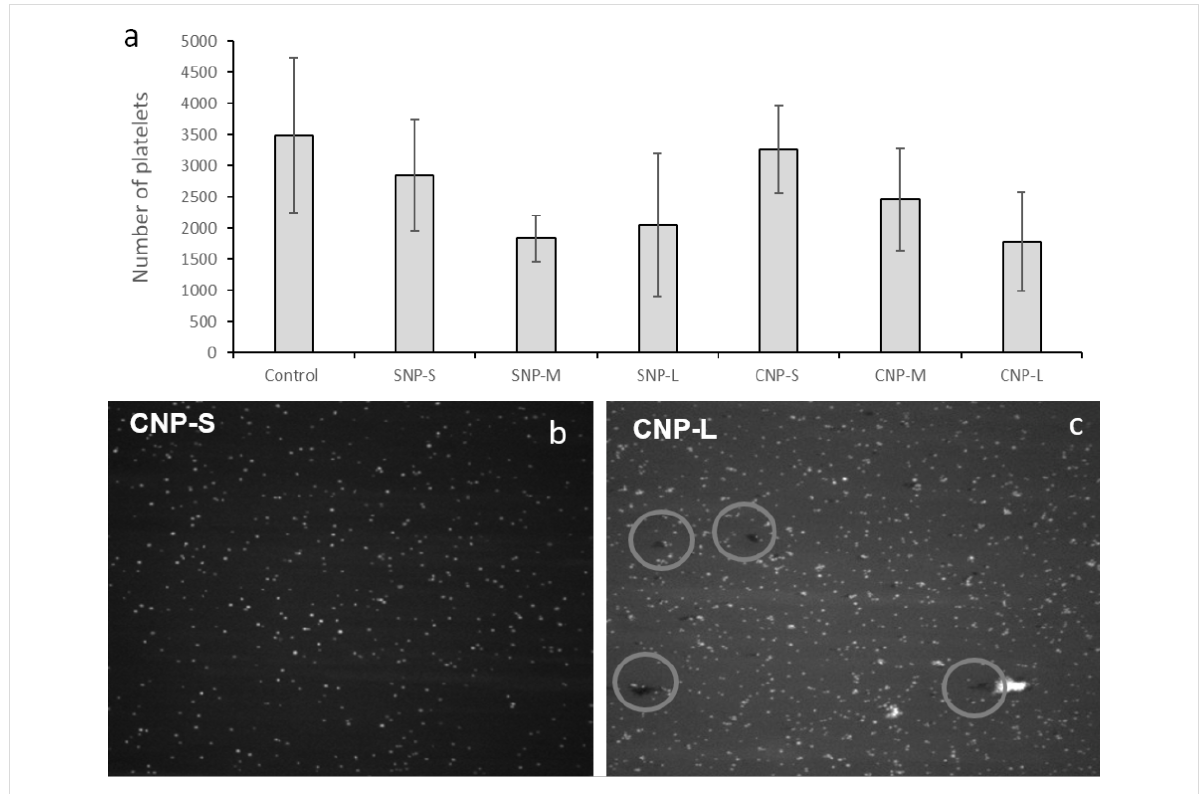
Figure 11: Effect of the nanoparticles on platelet adhesion. a) Total number of platelets adhering to the substrate; b) and c) representative images of the substrate during the measurements for CNP-S and CNP-L,